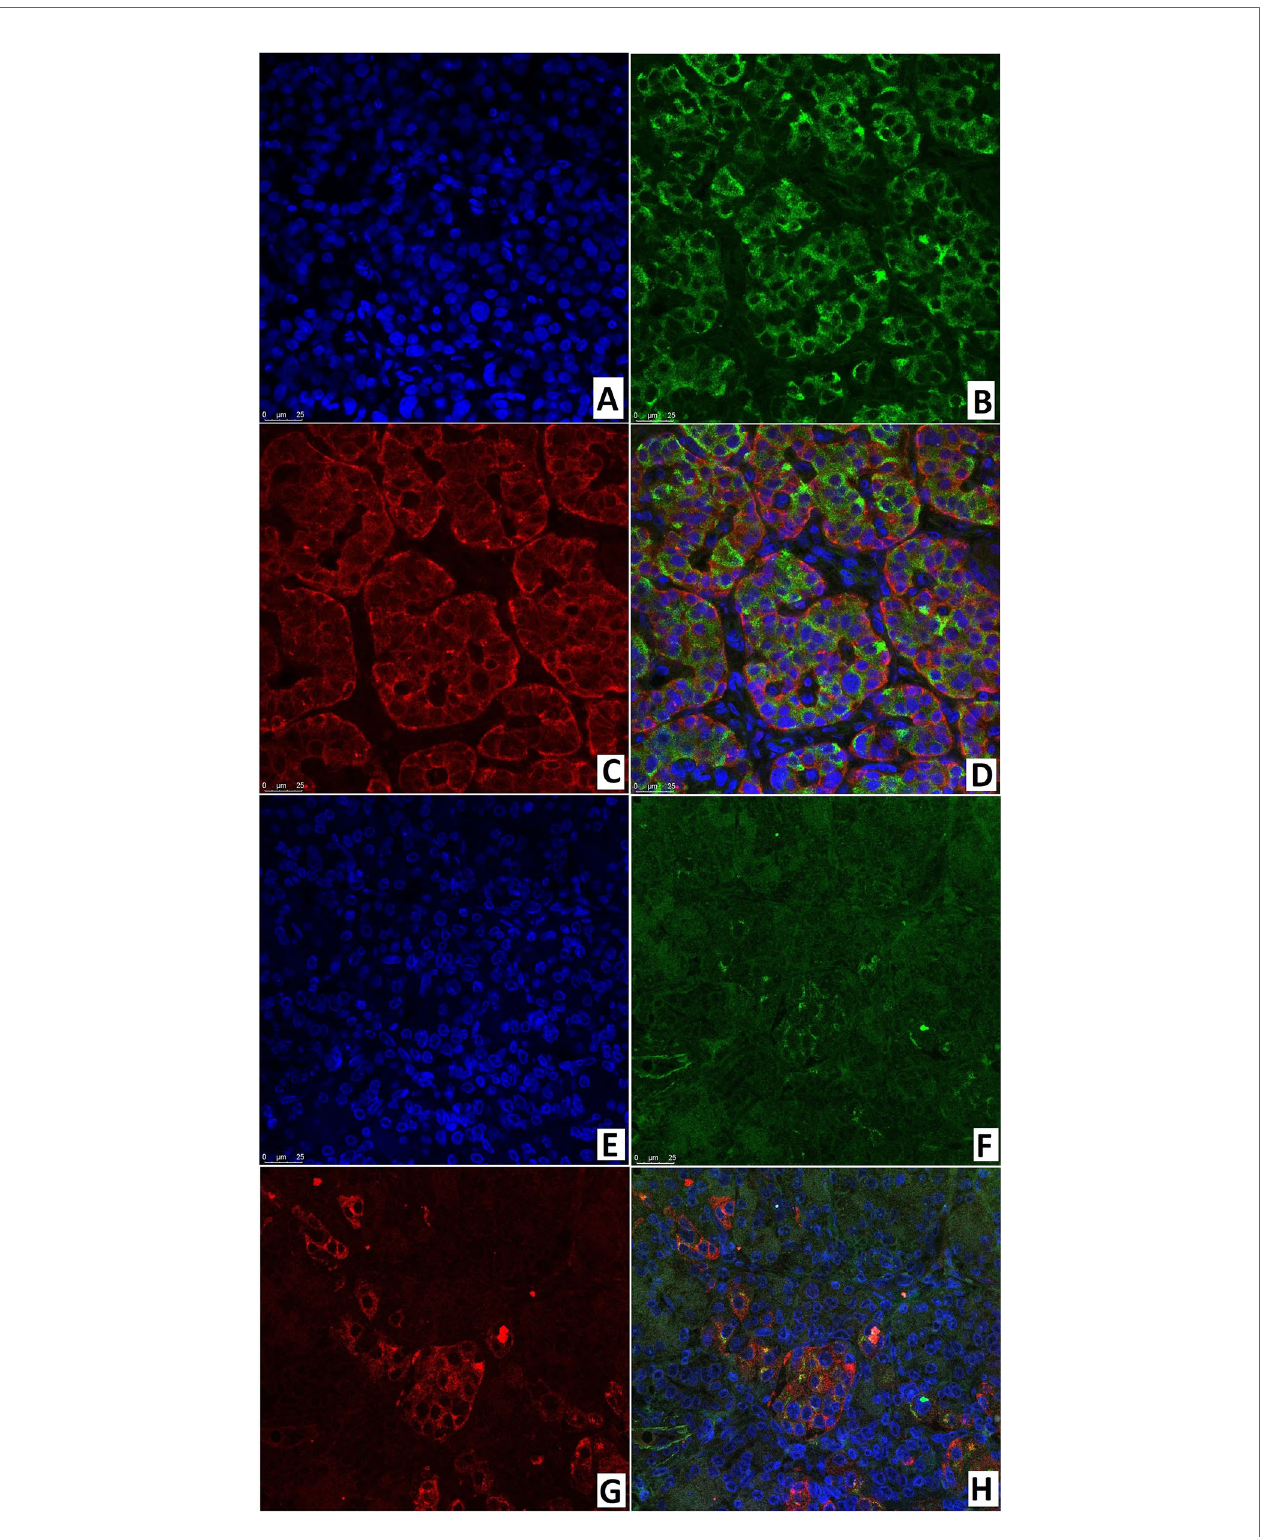
FIGURE 13 | Confocal laser scanning microscopy of the pancreas in congenital hyperinsulinism. (A – D) focal form, (E – H) diffuse form. (A, E) : blue fl uorescence of cell nuclei (DAPI). (B, F) : green fl uorescence of insulin in cytoplasm. (C, G) : red fl uorescence of SSTR2. (D, H) : coexpression of insulin and SSTR2 observed as orange fl uorescence;